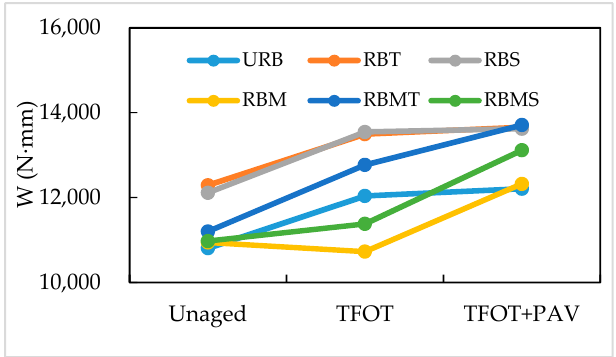
Figure 9. Effect of modification methods on the fracture energy of rubberized bitumen. Figure 9. E ff ect of modification methods on the fracture energy of rubberized